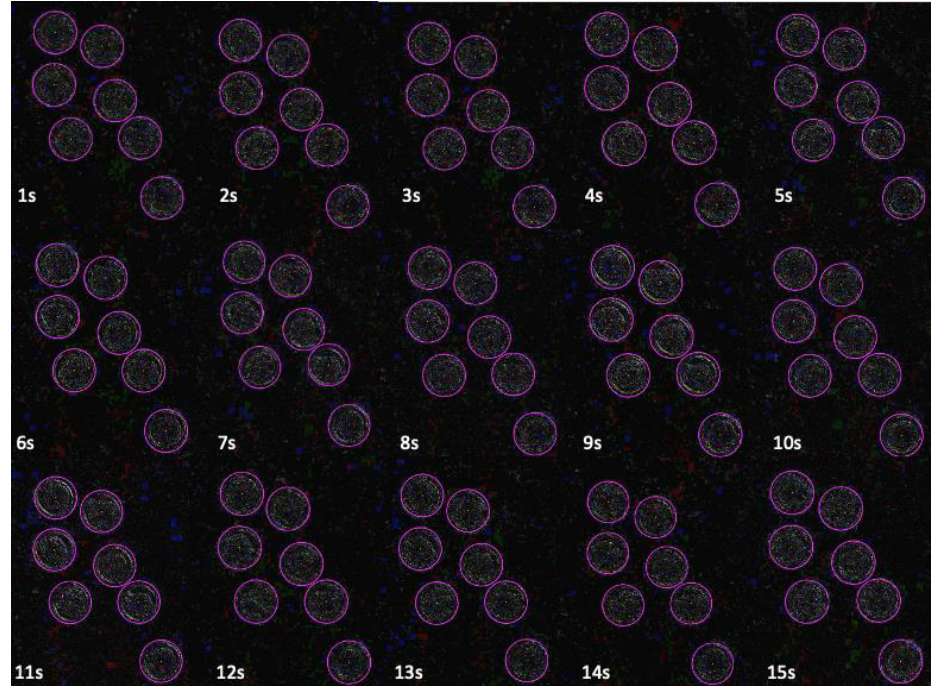
Figure 6. Image subtraction and contrast boosting images of bovine embryos. Videos, recorded at 15 frames per second, were processed with graphic imaging techniques. Still capture images of the video data at 1 image per second were placed in a schematic to represent detectable changes in the embryos over a 15 s period. Image collected on an SMZ-1000 stereo zoom microscope, 90 ×